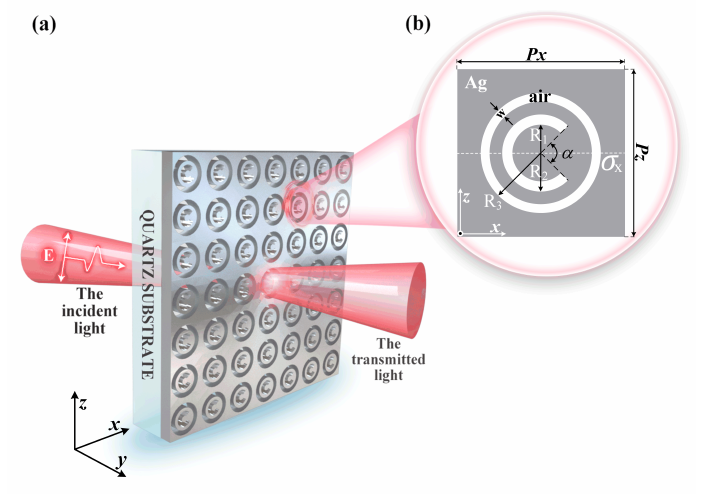
Figure 1. ( a ) Sketch of a hybrid rotational misalignment metasurface composed of periodic silver (Ag) thin-film arrays with concentric C-shaped- (CSA) and circular-ring-aperture (CRA) unit cells. The linearly polarized incident light interacts with the Ag film and propagates from the bottom of the quartz substrate (along the positive Y-direction). ( b ) Structural cross-sectional diagram of a unit cell in the X–Z plane. The gray and white parts represent the Ag film and air, respectively. R 1 and R 2 are the inner and outer radii of the CSA structure, respectively. α denotes the opening angle of the CSA structure. w and R 3 depict the width and outer radius of the CRA structure, respectively. P x and P z are the periodic lengths of the Ag array in X and Z directions,